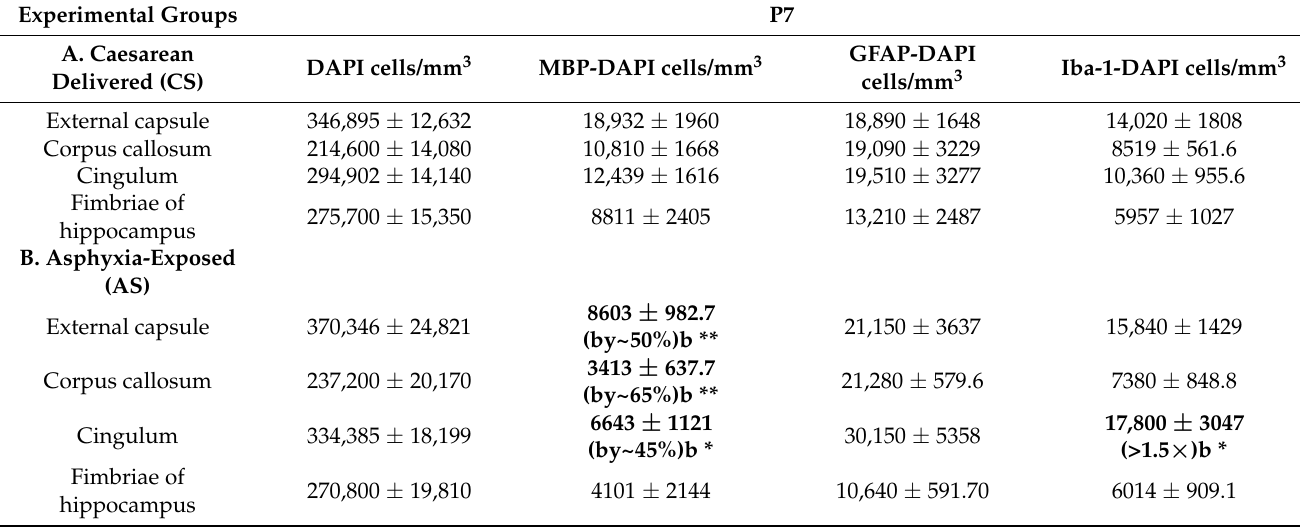
Table 4. Effect of perinatal asphyxia (PA) on glial cells measured in telencephalon (external capsule, corpus callosum, cingulum) and fimbriae of hippocampus at P7. Control (CS) versus asphyxia-exposed (AS) rats, focusing on mature OLs (MBP), astrocytes (GFAP), and microglia (Iba-1). Coronal sections of telencephalon and hippocampus were treated for immunohistochemistry against MBP, GFAP, Iba-1, and counterstained with DAPI. Microphotographs (two-five samples per brain region) were taken from external capsule, corpus callosum, cingulum, and fimbriae of hippocampus, in the field of a confocal-inverted Olympus-fv10i microscope with a 60 × . The mean number of the glial cells per mm 3 was estimated using ImageJ software. Data are shown as means ± S.E.M from at least n = 5 independent experiments. Student’s t -test indicated a significant effect of PA on MBP-DAPI cells/mm 3 in external capsule (t = 3.472, d.f. = 8, p < 0.008); corpus callosum (t = 4.143, d.f. = 8, p < 0.003); cingulum (t = 2.947, d.f. = 8, p < 0.019), but not in fimbriae of hippocampus (t = 1.462, d.f. = 8, p = 0.174). No significant differences were observed when comparing AS versus CS animals on GFAP-DAPI cells/mm 3 in the external capsule (t = 0.564, d.f. = 8, p = 0.588); corpus callosum (t = 0.669, d.f. = 8, p = 0.523); cingulum (t = 1.696, d.f. = 8, p = 0.128), and fimbriae of hippocampus (t = 1.003, d.f. = 8, p = 0.345). Significant differences were observed when comparing AS versus CS animals on Iba-1-DAPI cells/mm 3 in the cingulum (t = 2.329, d.f. = 8, p < 0.048), but not in external capsule (t = 0.793, d.f. = 8, p = 0.451); corpus callosum (t = 1.118, d.f. = 8, p = 0.296); and fimbriae of hippocampus (t = 0.042, d.f. = 8, p =